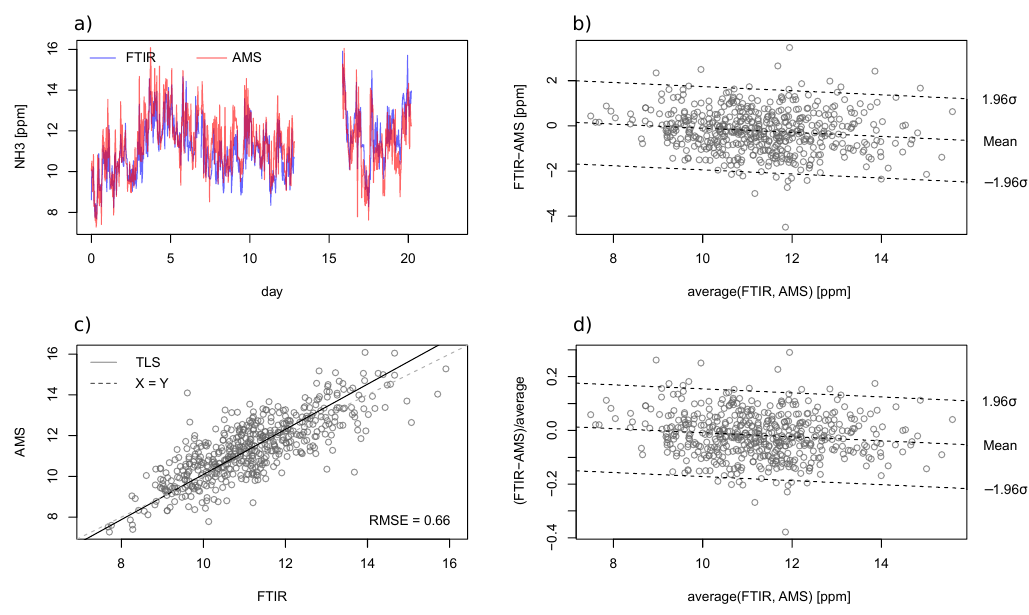
Figure 6. Comparison of sub-hourly NH 3 measurements between AMS and FTIR in the occupied compartment test. The sub-plots are: the ( a ) time-series plot, ( b ) Bland–Altman plot of absolute differences, ( c ) scatter plot, and ( d ) Bland–Altman plot of the relative difference. The dashed lines in the Bland–Altman plots represent the regression line and 95% bound of